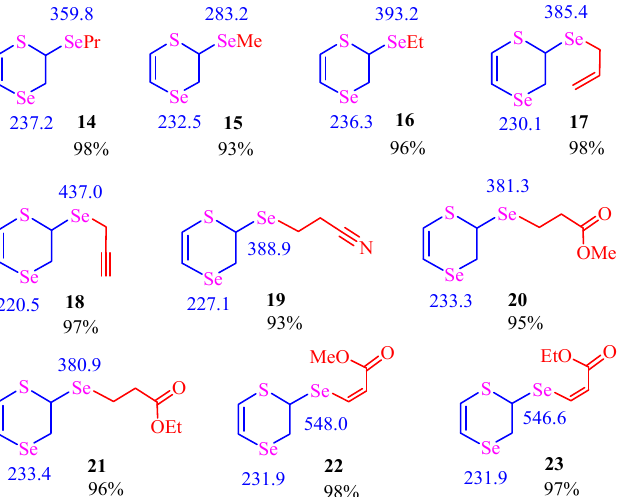
Scheme 4. The obtained (1,2 ‐ dihydro ‐ 1,4 ‐ thiaselenin ‐ 2 ‐ yl) selenides 14–23 and the 77 Se ‐ NMR data (colored in blue,